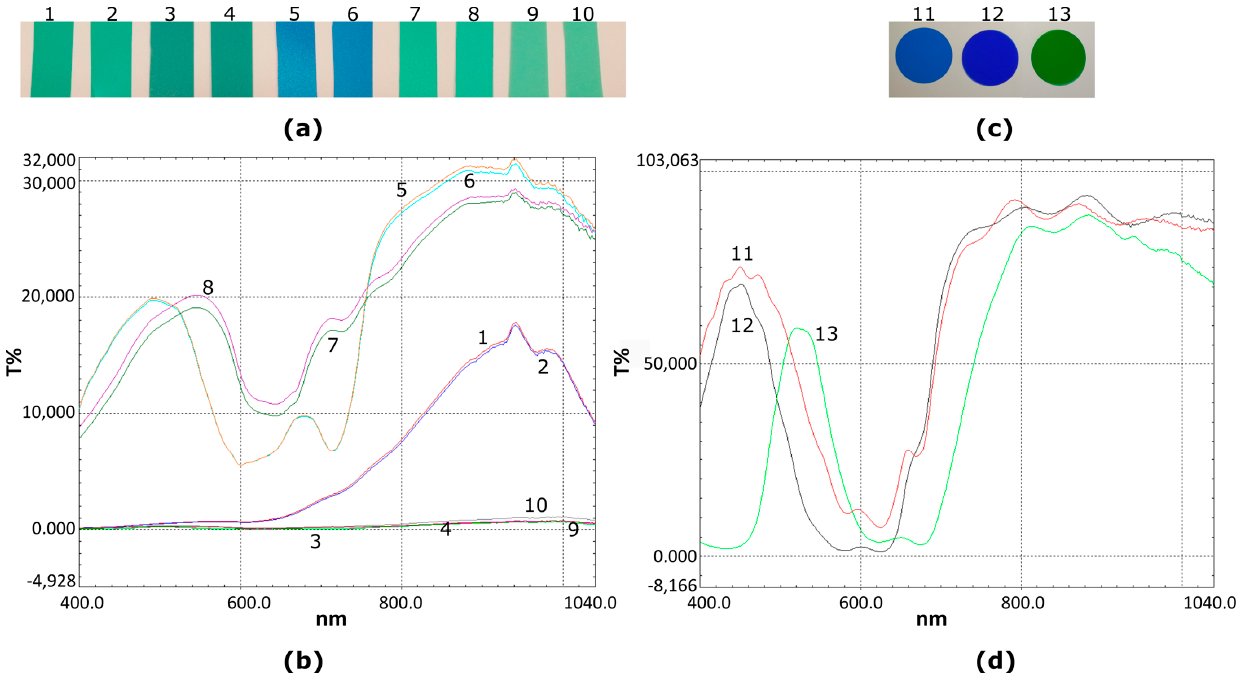
Figure 7. Color plastic filters in 5 different shades of green (no. 1, 2, 3, 4, 7, 8, 9, 10 in ( a ) and 13 in ( c )) and 3 different shades of blue (no. 5, 6 in ( a ), 11, 12 in ( c )) used for a low-cost evaluation of accuracy and repeatability of the 3 sensors. In ( b , d ) the transmission spectra of the samples are shown as acquired with a spectrophotometer. The numbers in the transmission spectra correspond to the numbers of the sample color filter used.